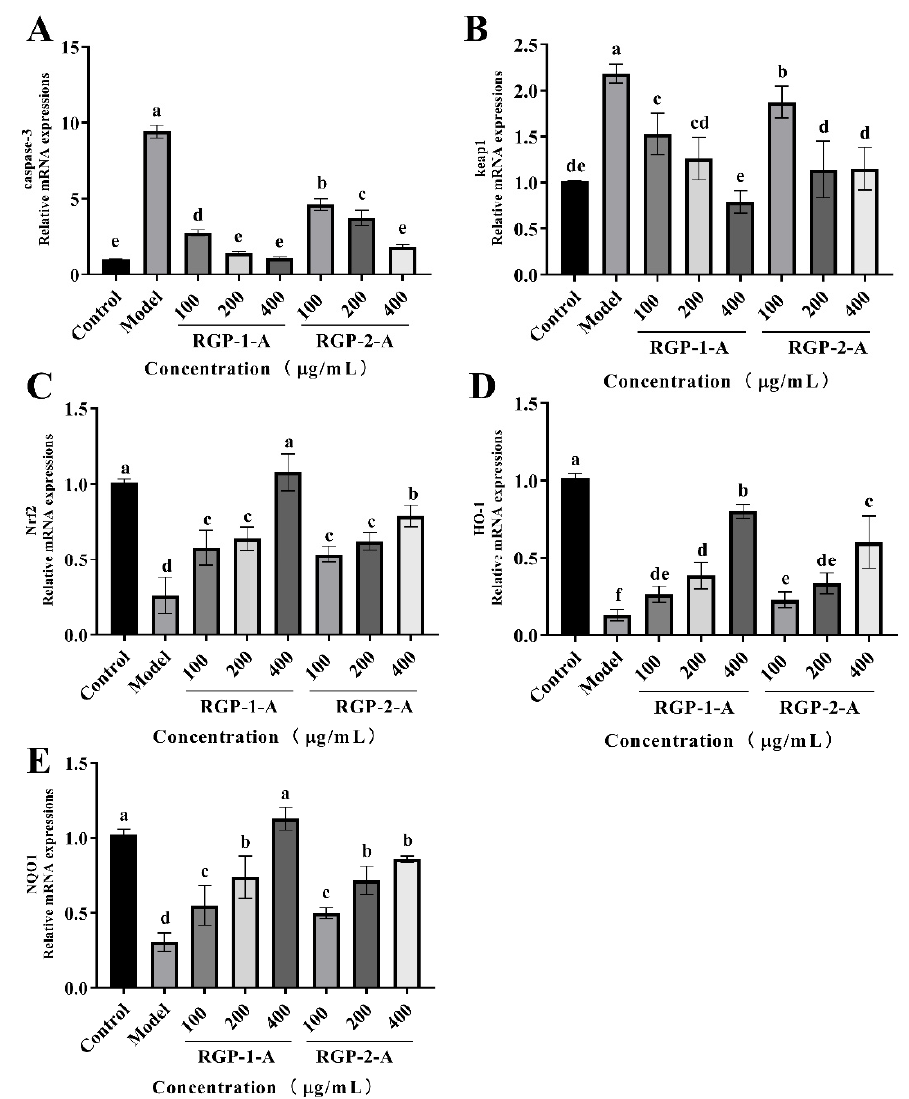
Figure 10. RGP increased the mRNA expression of genes related to the Nrf2/Keap1 signaling pathway in IPEC-1 cells. The mRNA levels of these genes were detected using RT-PCR. ( A – E ) Effect of RGP (100, 200, and 400 µ g/mL) on the mRNA expression of caspase-3 ( A ), Keap1 ( B ), Nrf2 ( C ), HO-1 ( D ), and NQO1 ( E ). The mRNA levels of all genes were normalized to those of GAPDH. RGP − 1 − A: Rehmannia glutinosa polysaccharides decolorized by the AB-8 macroporous resin; RGP − 2 − A: Rehmannia glutinosa polysaccharides decolorized by H 2 O 2 . Different lowercase letters on the bar graph indicate significant differences ( p < 0.05).